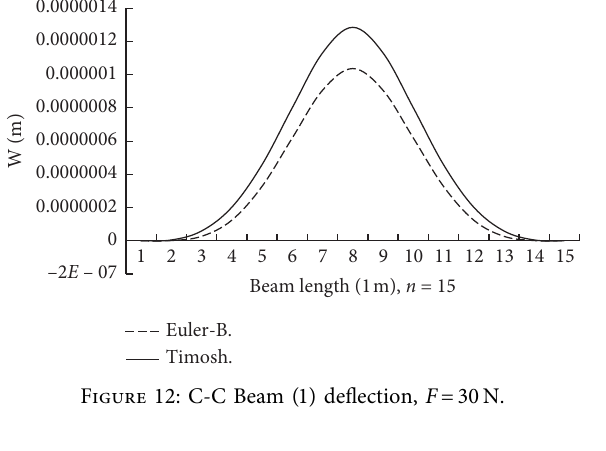
Figure 15: C-C T Beam (2) cross-section rotation.